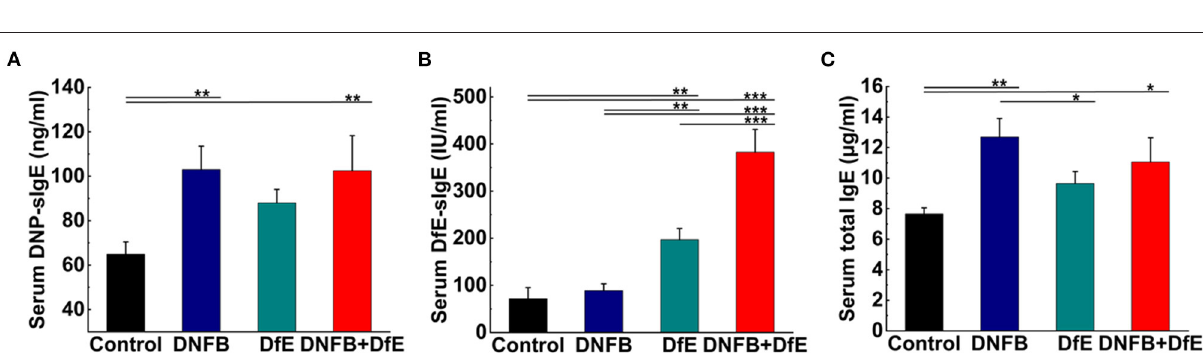
mast cells in the upper dermis, increased remarkably. What‘s more, the levels of serum total IgE, DfE-sIgE, and DNP-sIgE were increased in BALB/c mice. On the other hand, after repeated exposure to DNFB, the back skin of mice was mildly